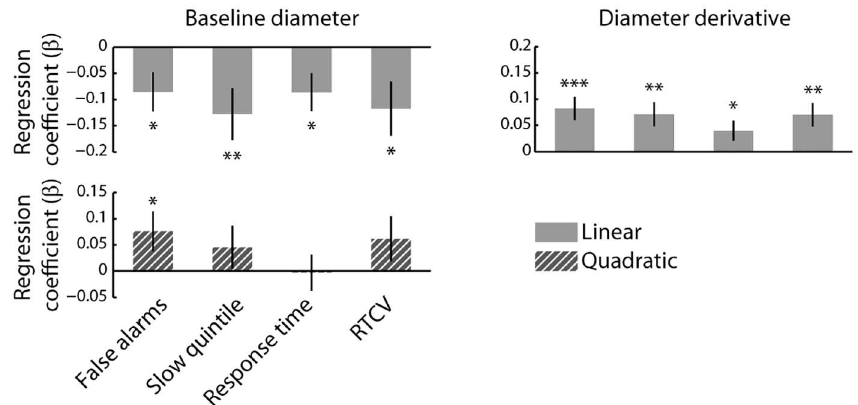
Fig 4. The relationship between pupil diameter and behavior. Regression coefficients are shown per pupil measure and behavioralmeasure. USD: Units standard deviation.Error bars represent the SEM. * : p < 0.05; ** : p < 0.01; *** : p <